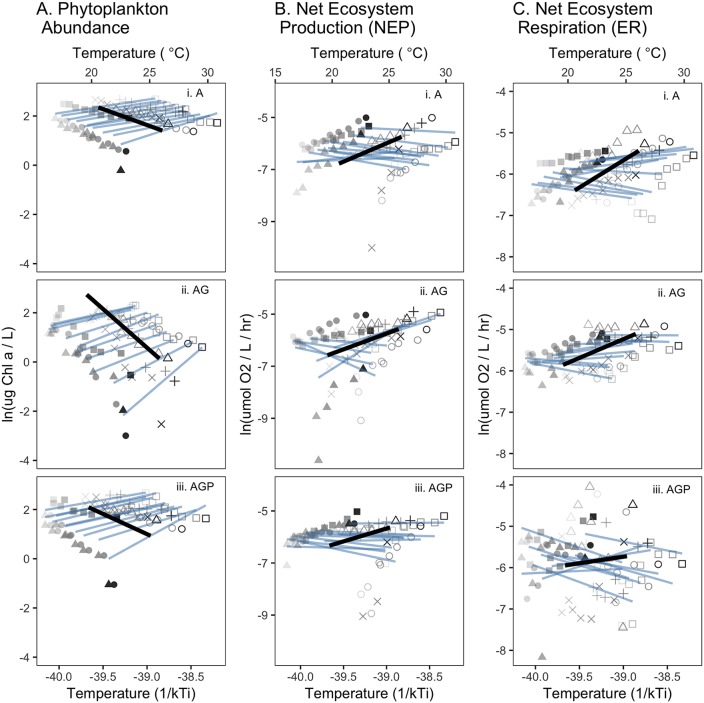
The effect of ecosystem temperature (Twj) on (A) phytoplankton biomass, (B) NEP, and (C) net ER for three community types that varied in their trophic interactions: (i) algae-only (A), (ii) algae + grazers (AG), and (iii) algae + grazers + notonectid predators (AGP).There were 10 ecosystems (j) in each trophic treatment, and each ecosystem was sampled 8 times (once per week from weeks 2 to 9). Each week is indicated by a symbol shape, and ecosystem identities within weeks are distinguished by shades of gray. In a single model (Eq 13), we considered effects of temperature within ecosystems over time, as well as among-ecosystem variation in mean temperature (Figs 2 and 5). Blue lines are fit to the 8 observations (points) from each ecosystem (one from each week), and their slope indicates within-ecosystem temperature effects estimated from best models in Tables 2, 6 and 7. Black lines indicate the modeled among-ecosystem effects of temperature (Tables 1, 6 and 7; Figs 2A and 5). Temperature in Celsius is shown for comparison only; models were fit to inverse temperature. Temperatures within tanks declined over time (S2 Fig). Data for these figures may be found at https://doi.org/10.5281/zenodo.2652579 in GarzkeAllwks.csv. A, algae only; AG, algae and grazers; AGP, algae, grazers, and predators; ER, ecosystem respiration; NEP, net ecosystem production.